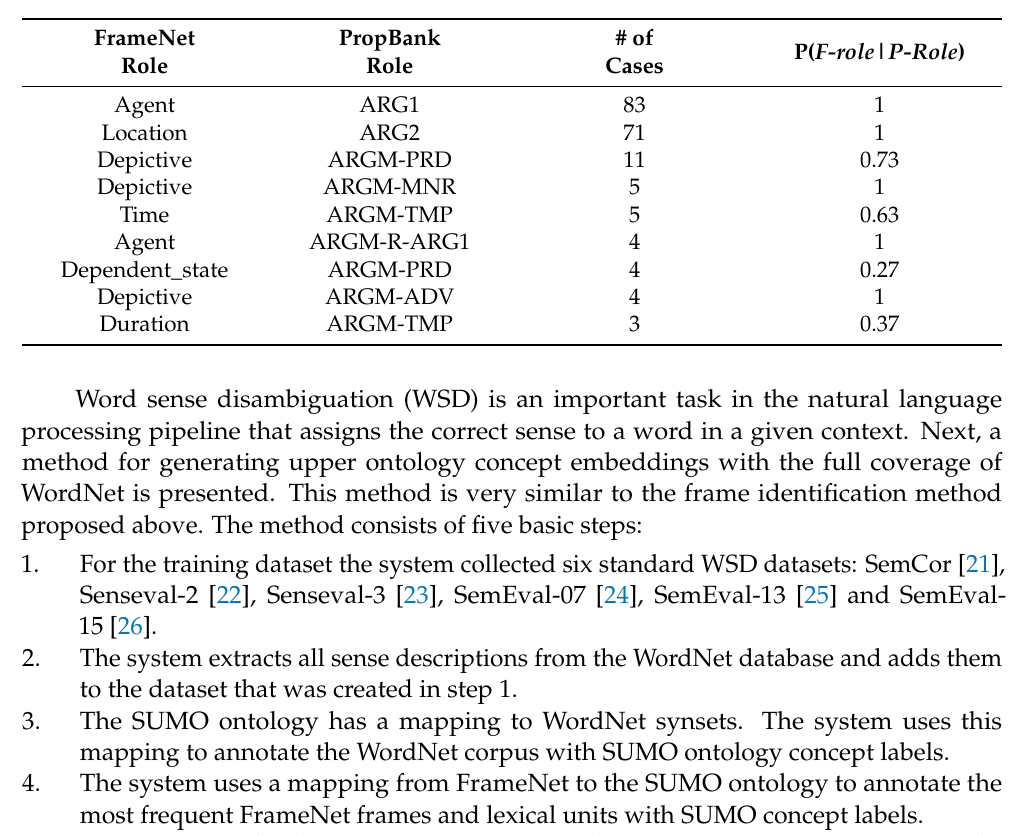
Table 3. Statistics for the frame < Posture > and the verb “ stand ” in the FrameNet corpus after the system has parsed it using the AllenNLP system (P-Role stands for PropBank role and F-role stands for FrameNet